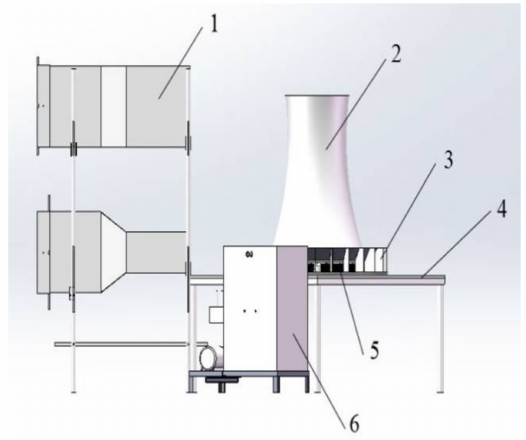
Figure 1. Schematic diagram of experimental system. 1—Natural-wind-simulating system; 2—Cooling tower; 3—Wind deflector; 4—Experiment table; 5—Radiators; 6—Water tank.